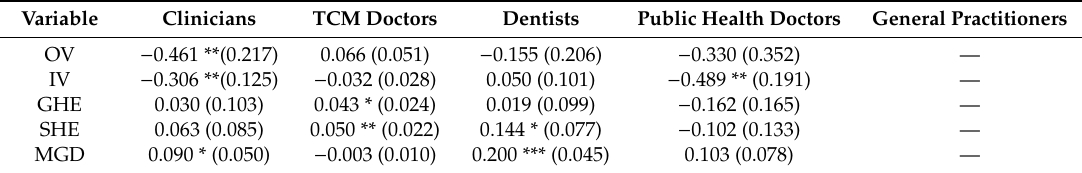
Table6. Spillovere ff ectsofindependentvariablesonthedensityofdi ff erentsubtypesoflicenseddoctors. Variable